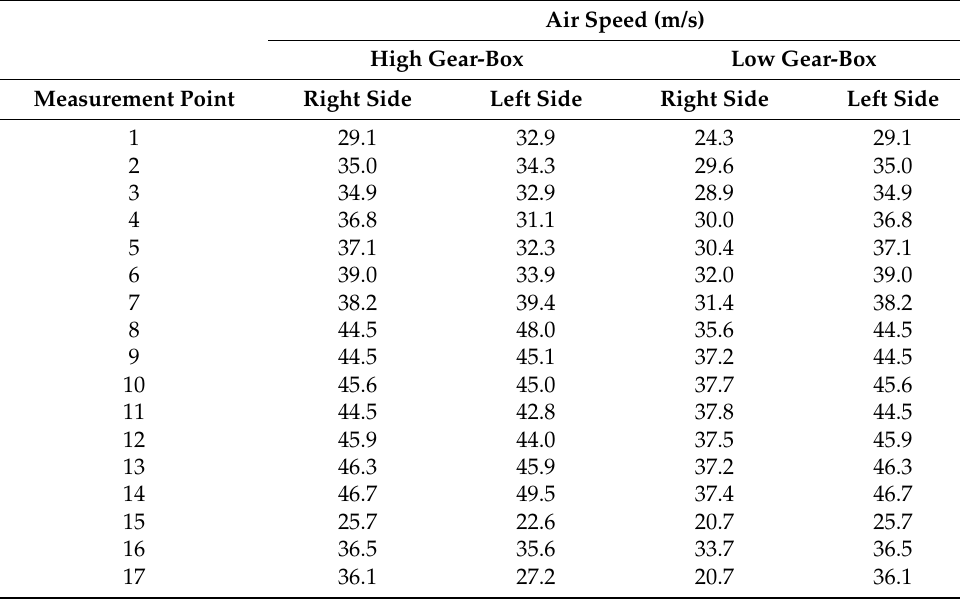
Table A25. Average air speed (m/s) in the measurement points of the C sprayer.